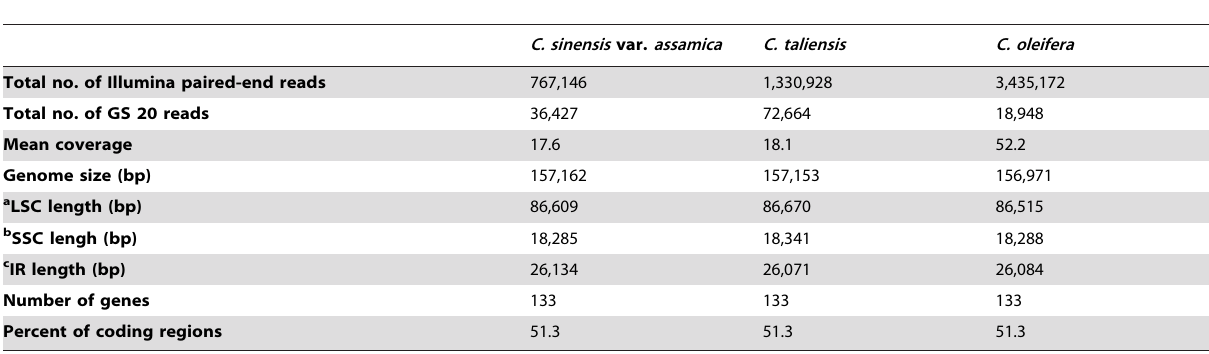
Table 1. Summary of the chloroplast genome sequencing, assembly and